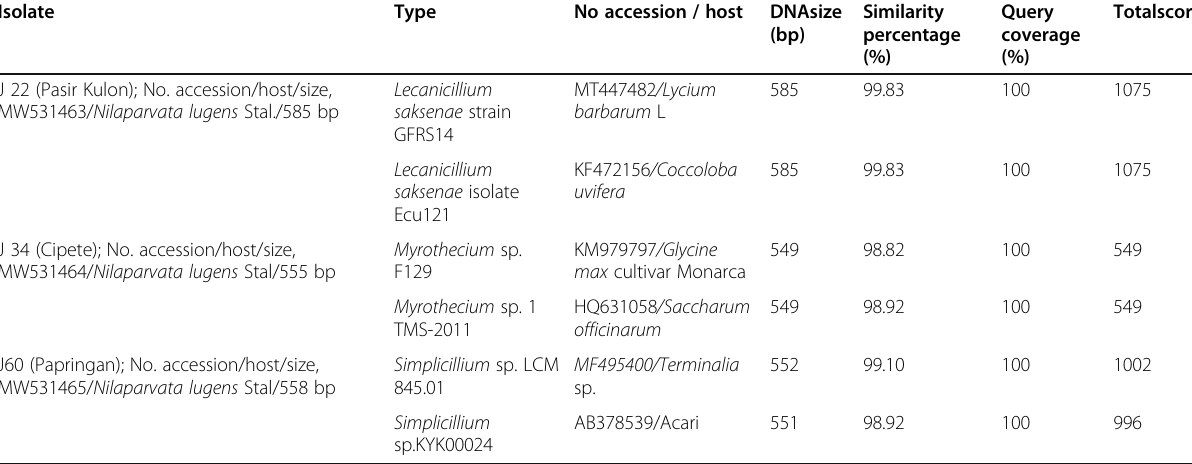
Table 2 Results of the nearest fungi taxon BLAST homology ITS1, 5.8S, and ITS2 of rDNA in NCBI (https://www.ncbi.nlm.nih.gov/)